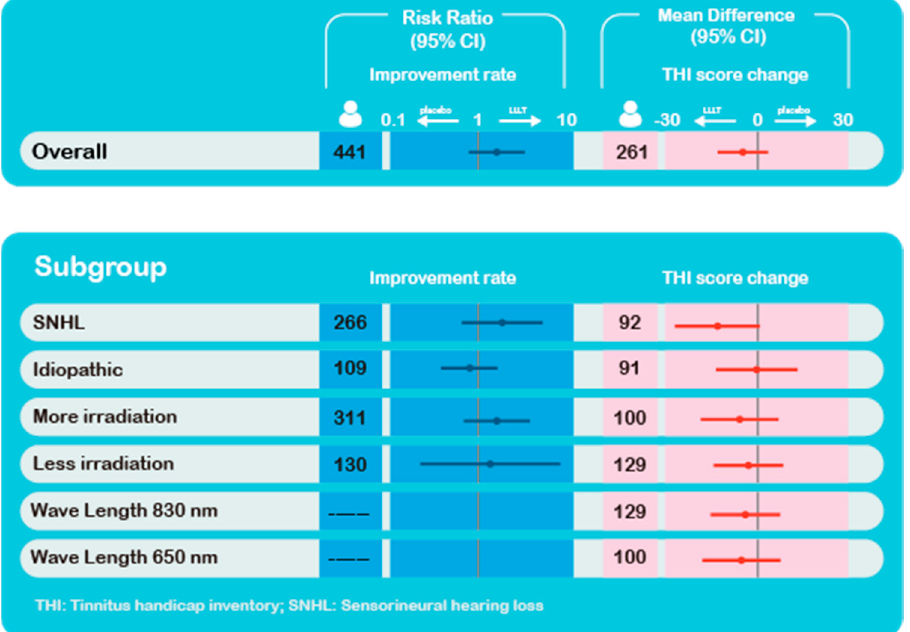
Figure 9. Visual summary of the results.